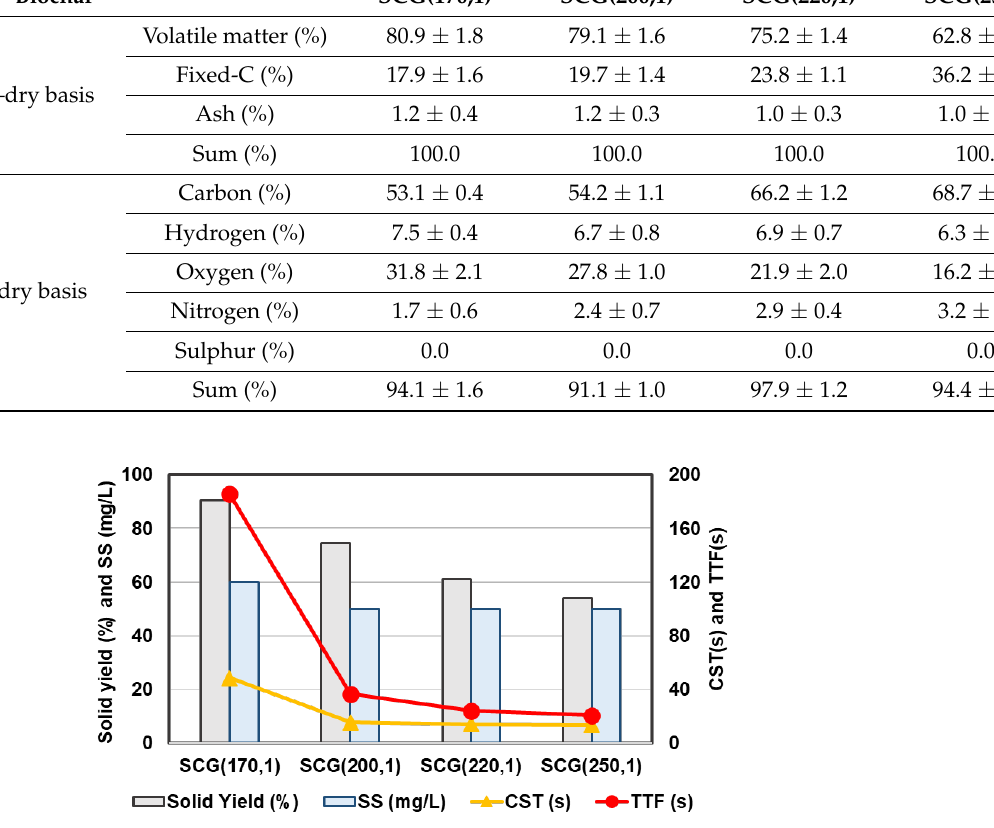
Figure 2. Solid yield (%), SS (mg/L), CST (s), and TTF (s) depend on SCGs. Capillary suction time (CST) and time to filter (TTF) are associated with the dehydra- tion of products. The results indicated that the HTC temperature increased with